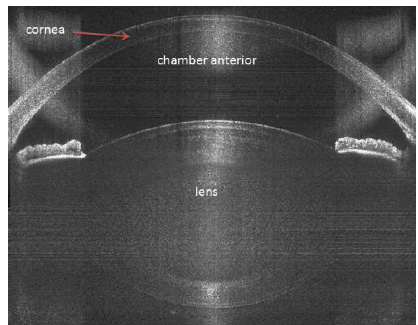
Figure 3. High-resolution OCT at a wavelength of 840 nm is mandatory for receiving a precise cut in the right position.